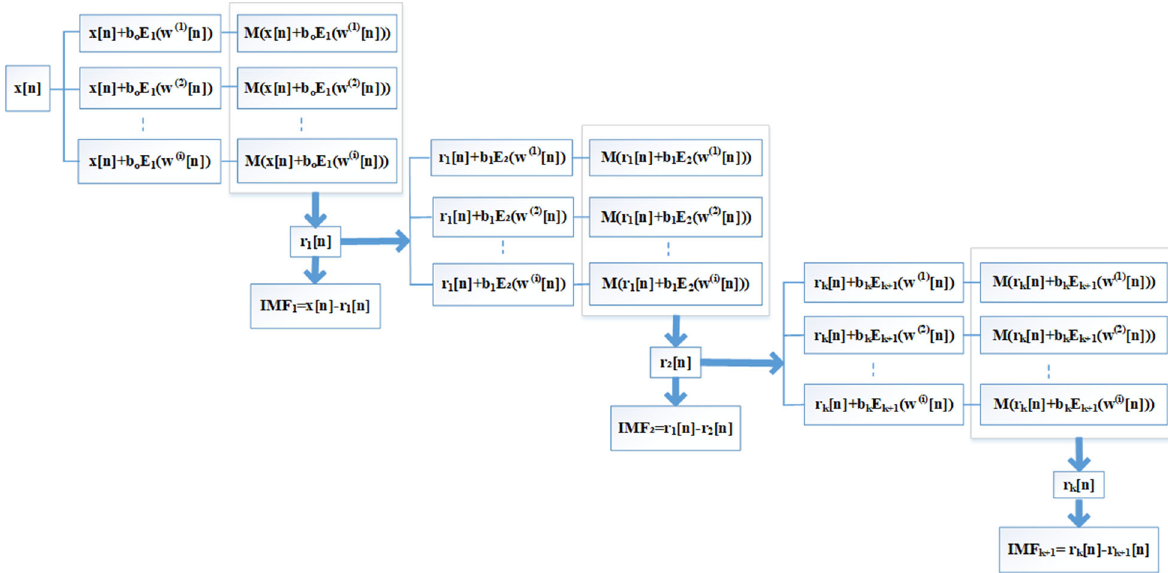
Fig. 1 Flow Chart of the ICEEMDAN